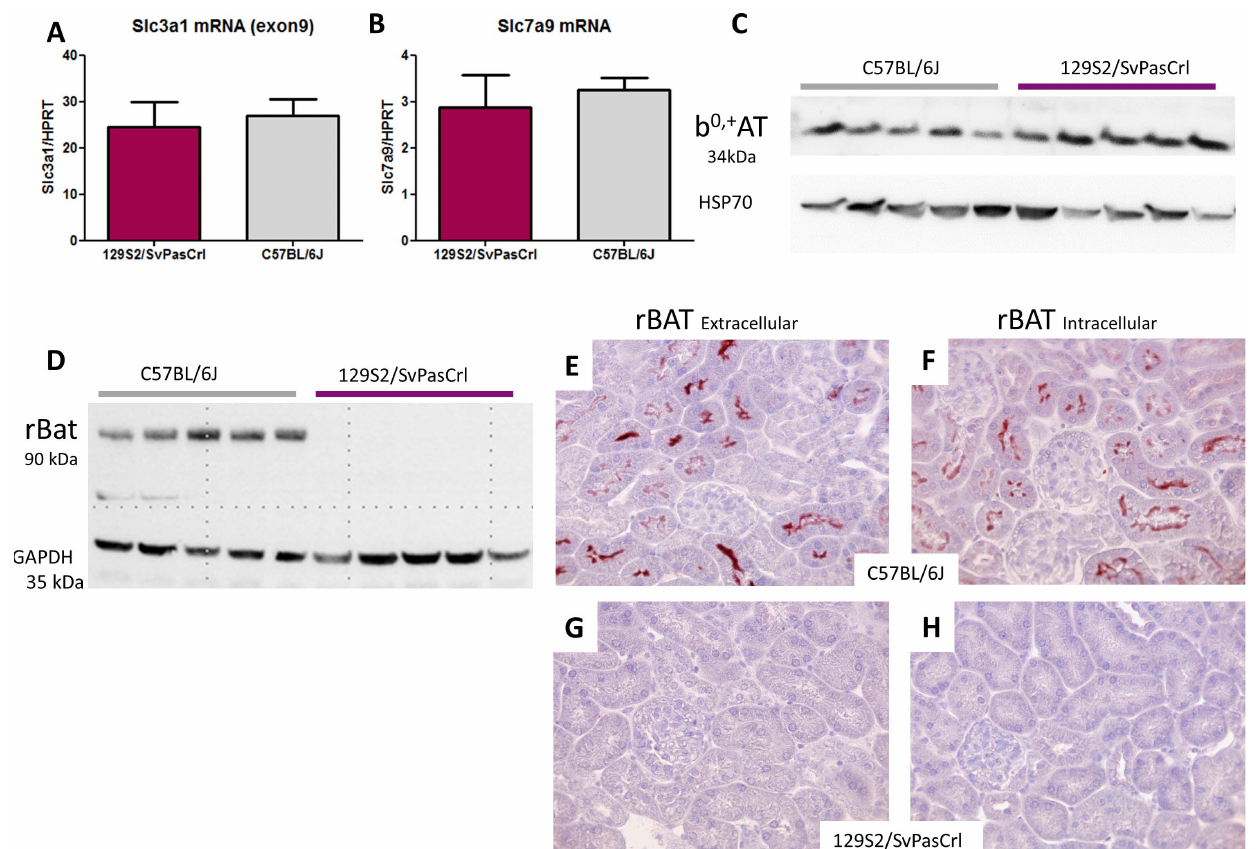
Figure 4. mRNA and protein expression of cystine transporters Slc3a1 /rBAT and Slc7a9 /b 0, + AT in kidney cortex from 129S2/SvPasCrl and C57bBL/6J mice. A–B , Quantitative PCR: Slc3a1 and Slc7a9 mRNA expression was similar in both strains. C , Western Blot: b 0, + AT was expressed at a similar level in kidney cortex from both strains. D , Western Blot: rBAT was expressed in C57BL/6 mice but not in 129S2/SvPasCrl mice. E–H , Antibodies directed against the extracellular part of rBAT (Figures 4E and 4G) or against its intracellular part (Figures 4F and 4H) revealed the presence of rBAT at the brush border of proximal tubular cells in C57BL/6J mice (4E and 4F) but not in 129S2/SvPasCrl mice (4G and 4H).